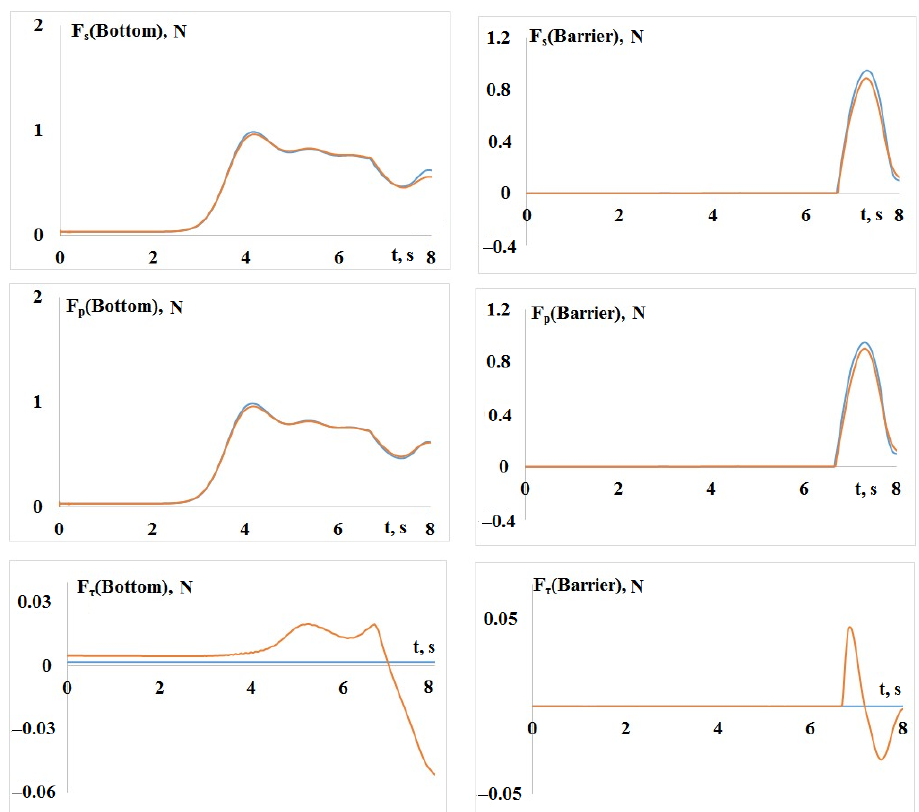
Figure 4. Comparison of the forces acting on the channel bottom in the slope and barrier zones ( —without TM, —with TM).